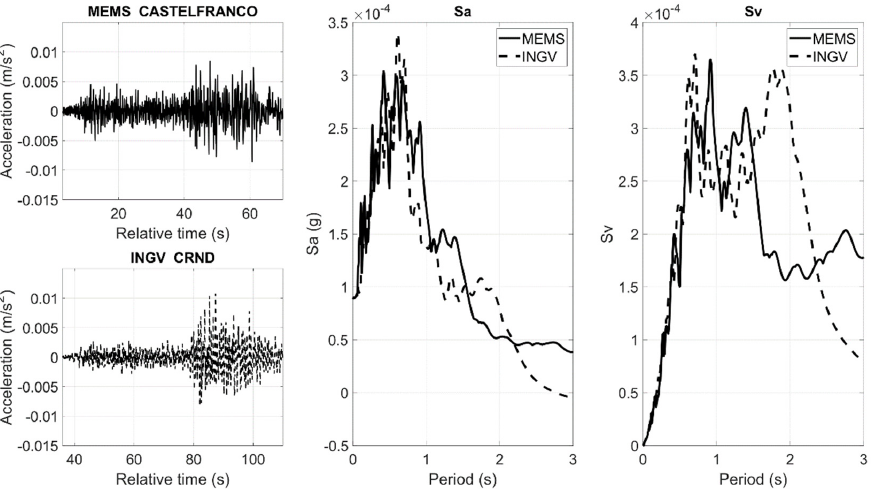
Figure 7. Comparison of the ASX1000 MEMS sensor prototype, CASTELFRANCO, and high—qual- ity sensors, CRND, belonging to the INGV networks. The comparison is made in terms of wave- forms, normalized Sa, and Sv.